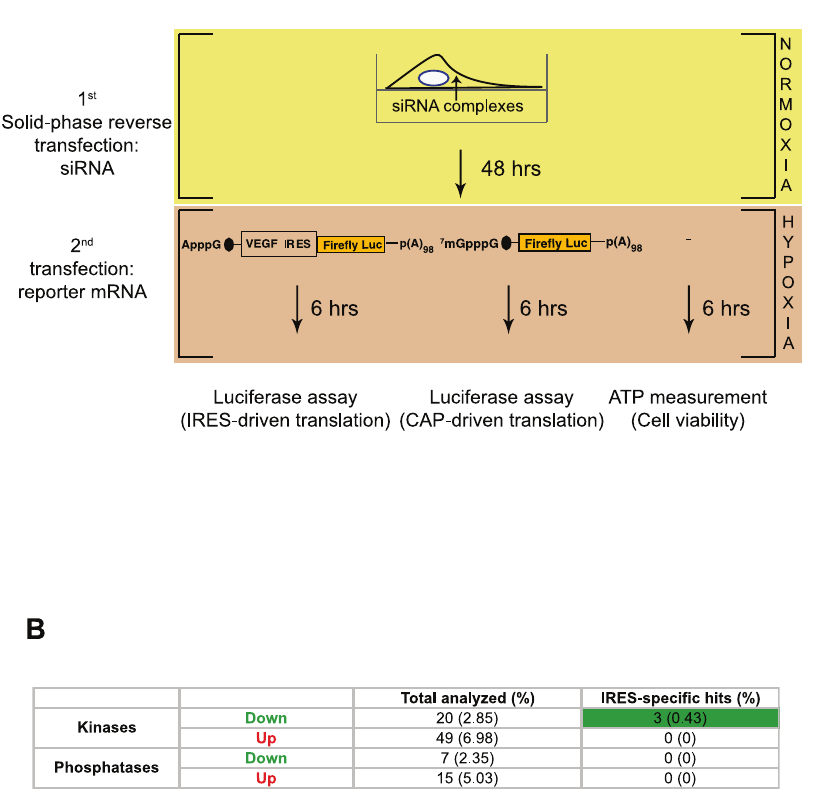
Figure 3. Secondary screen of 91 candidate regulators of VEGF IRES-dependent translation. (a) Workflow of the secondary screen . Cells were reverse-transfected with individual siRNAs designated as hits from the primary screen (Table S1 and S2). This was followed 48 hours later by three assays which were designed, respectively, to assess: 1) specificity of the effects for IRES-driven translation and 2) to determine effects on cell viability that might confound the other analyses. (b) Summary of secondary screening data.